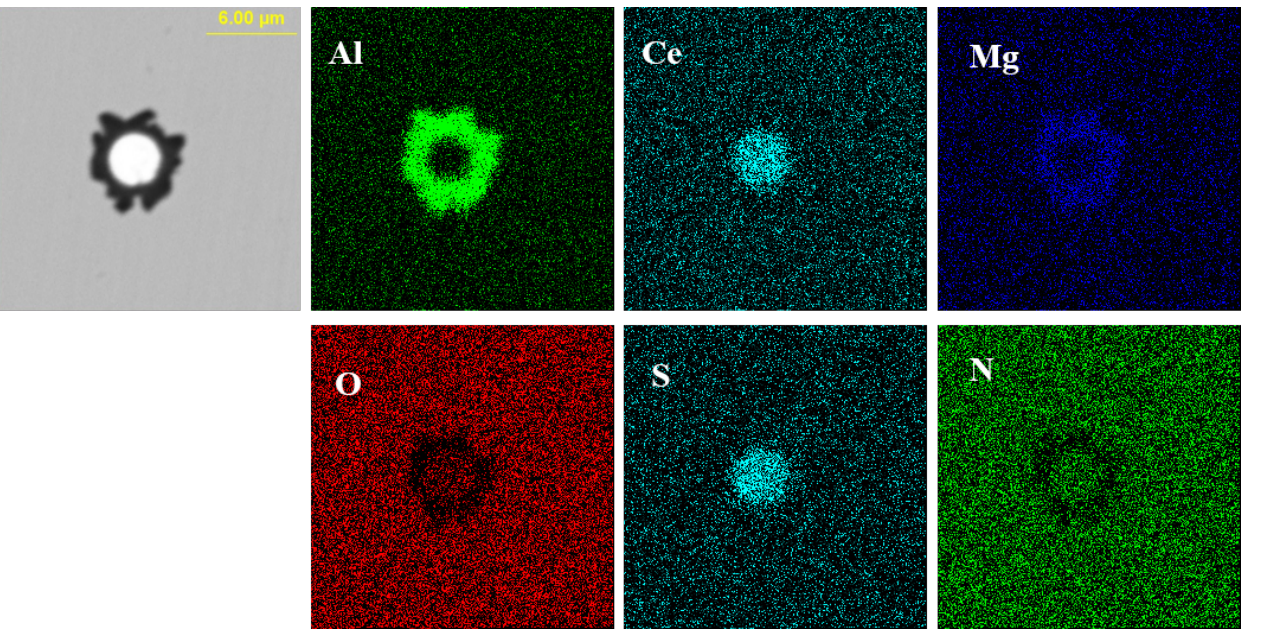
Figure 11. Elemental mapping of a typical inclusion in the steel with 60 ppm Ce content.